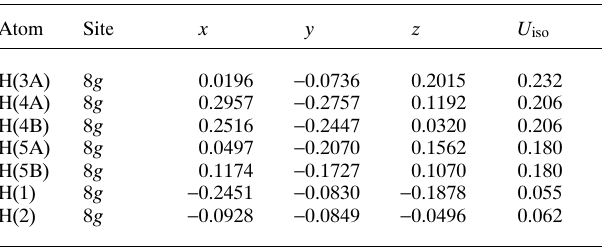
Table 2. Atomic coordinates and displacement parameters (in Å 2 )